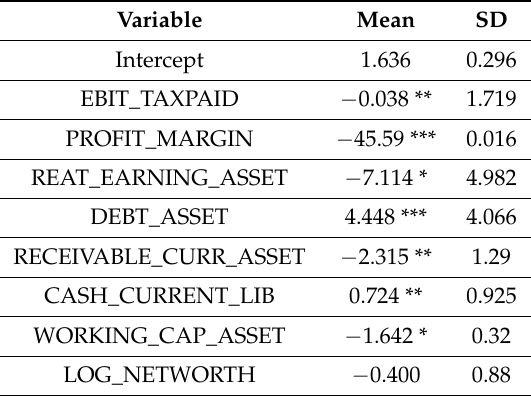
Table 4. Bayesian logistic estimation result.